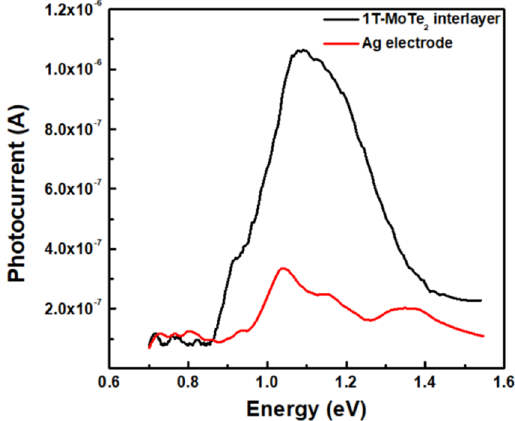
Figure 2. The PC spectra of Ag and 1T-MoTe 2 interlayer electrode contacts of 2H-MoTe 2 structures at 300 K.